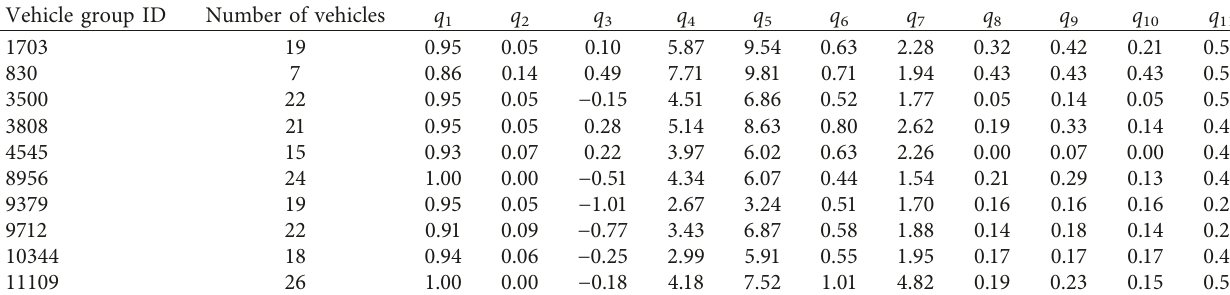
Table 5: Data processing